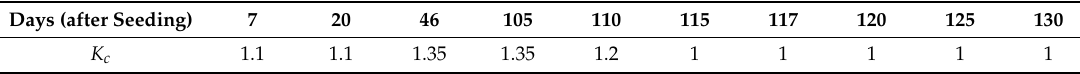
Table 3. Crop coefficient K c values for rice